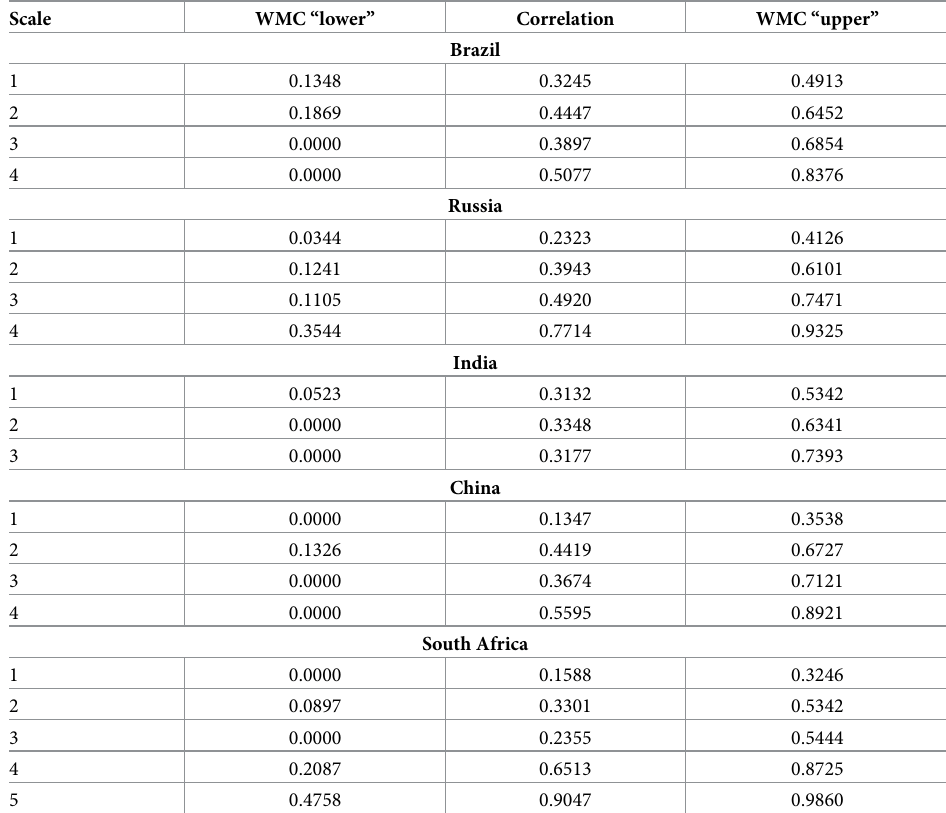
Table 3. Wavelet multiple correlations (WMC).